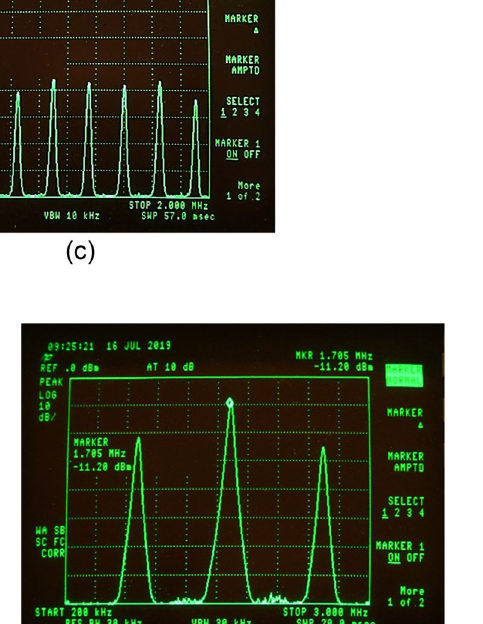
Fig. 7 a , b Positive or negative DC offset may suppress the oscillations. c Full spectra with harmonics, sub-harmonics and related combinations when the pump frequency is at 0.475 MHz. Note that the pump power is smaller at this lower end of the bandwidth. Here, the DC bias was ~ 0 V